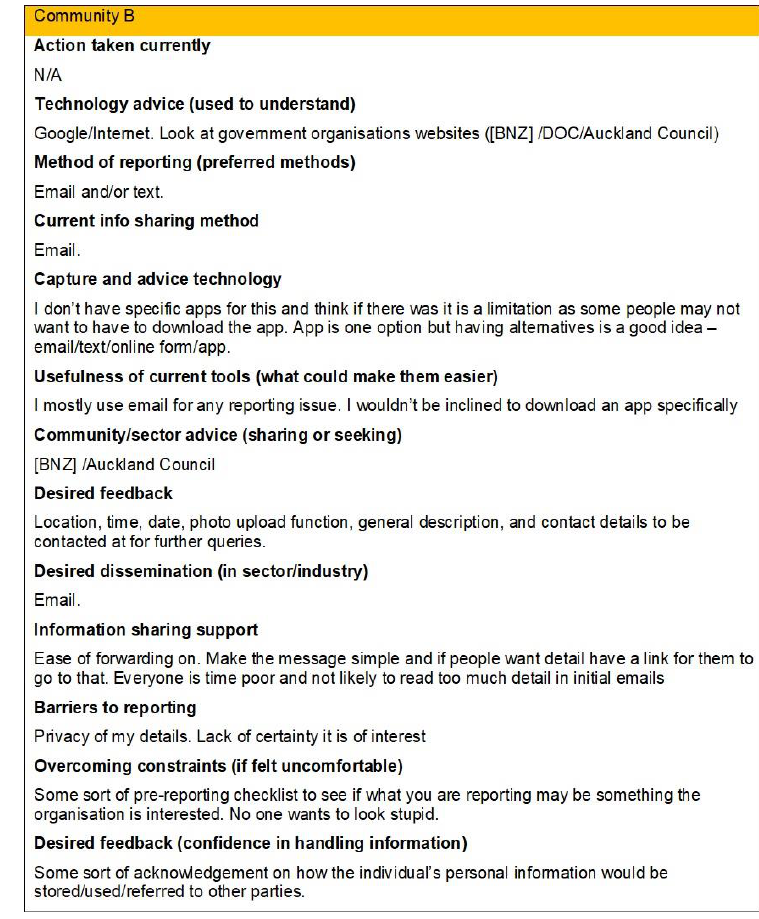
Figure A2. Sample mental model 2.